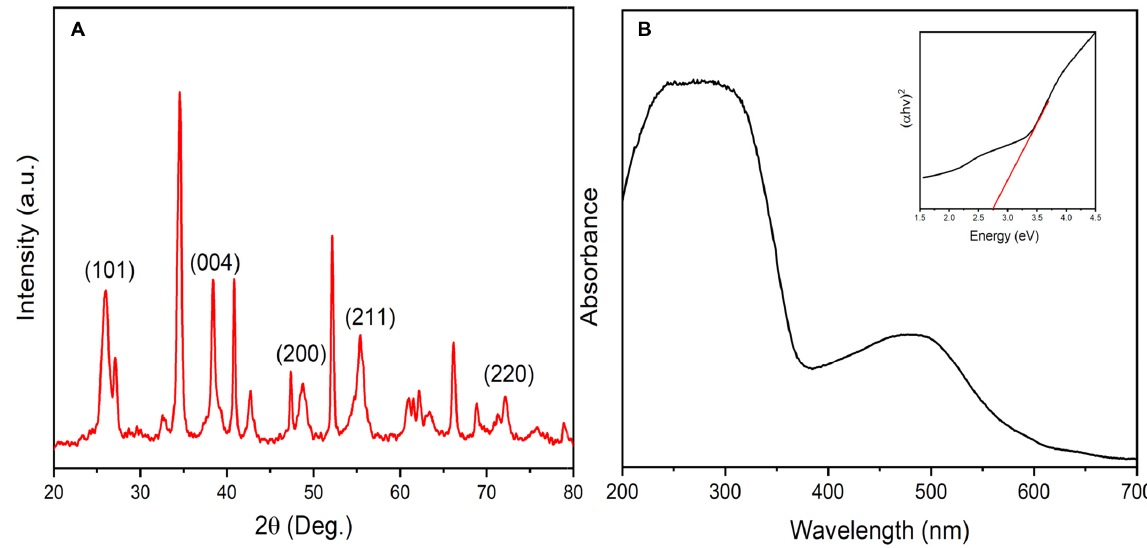
Figure 5. ( A ) p-XRD characterization of the PdO.TiO 2 ; ( B ) UV-Vis spectra of PdO.TiO 2 . Synthesized PdO.TiO 2 was explored for the photoelectrochemical splitting of